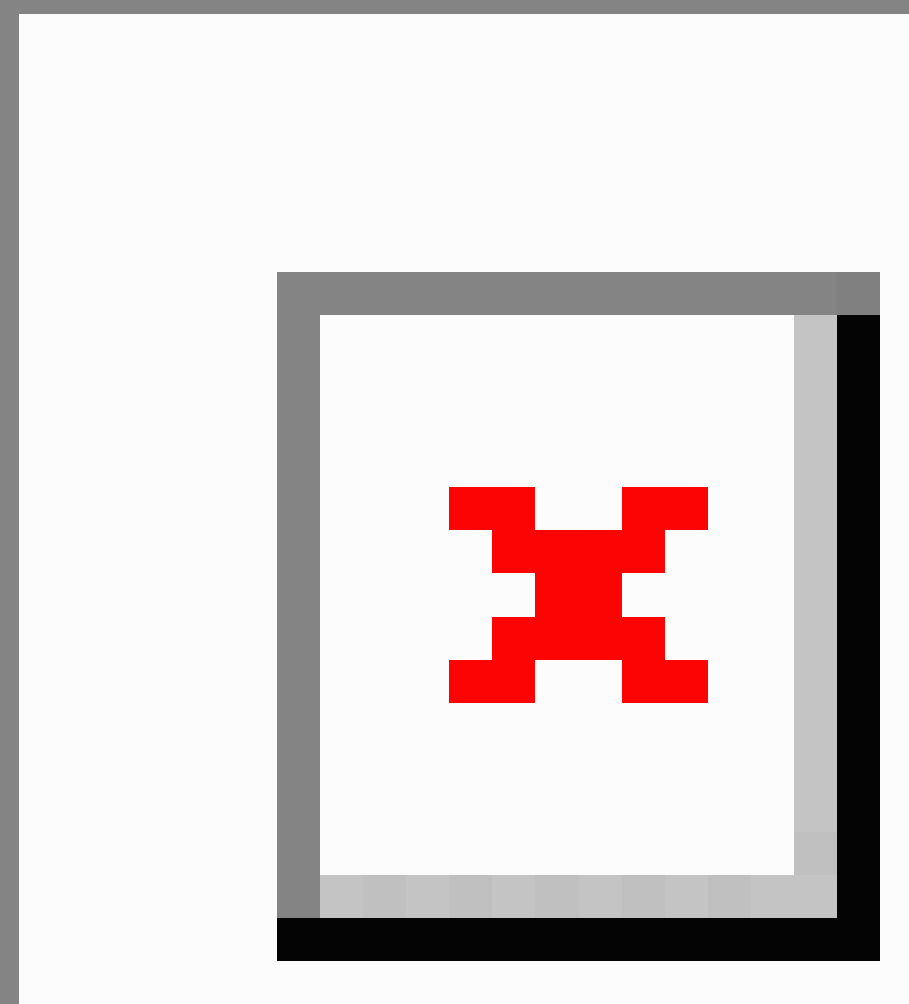
Figure 4. Business model view A from client